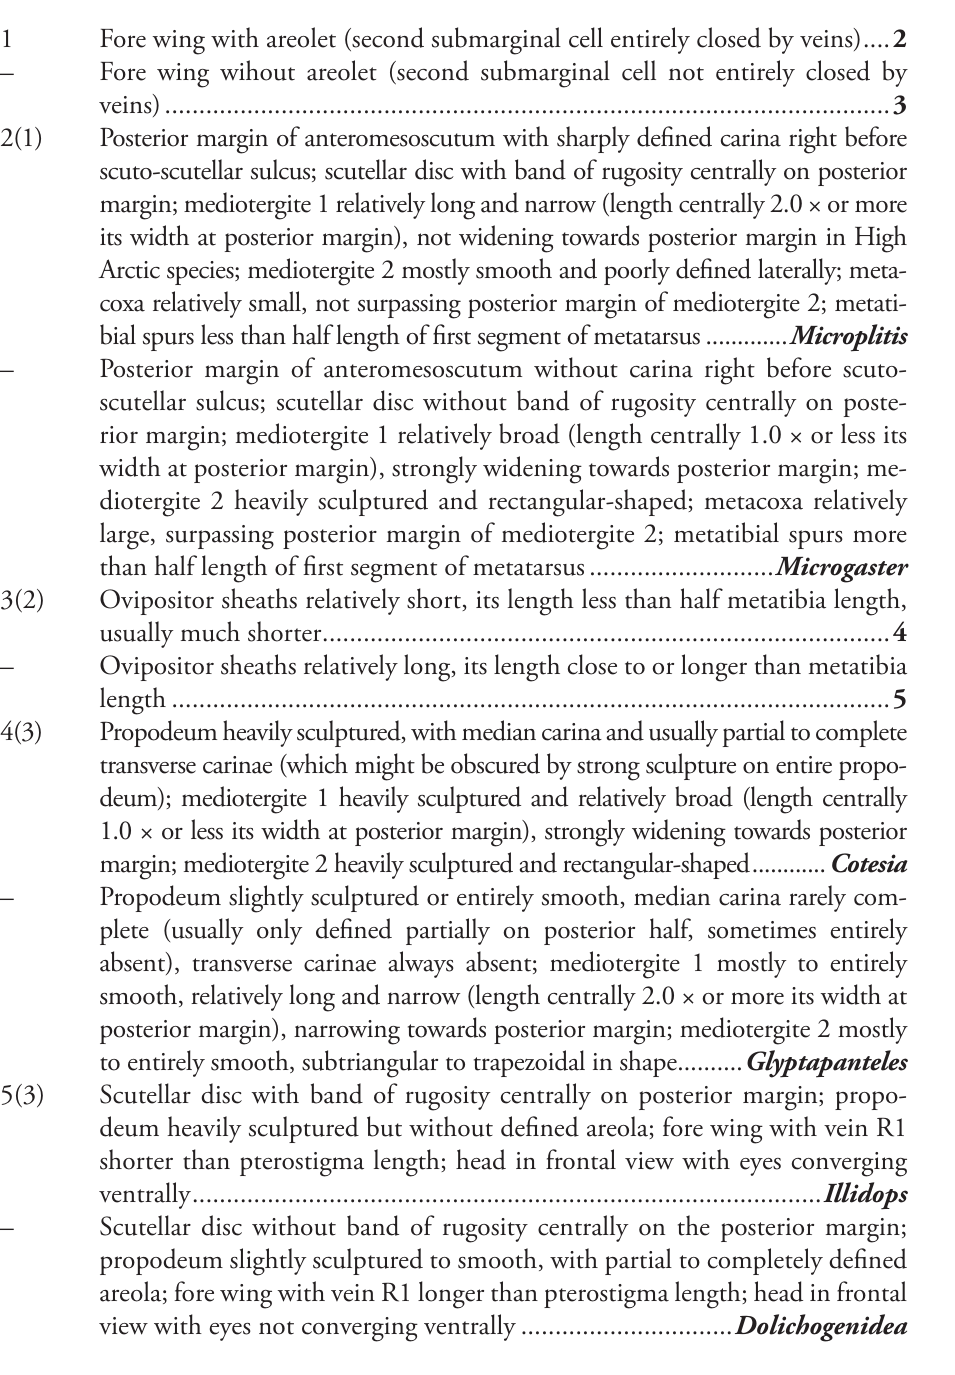
Fore wing with areolet (second submarginal cell entirely closed by veins) .... 2 Fore wing wihout areolet (second submarginal cell not entirely closed by 2(1) Posterior margin of anteromesoscutum with sharply defined carina right before scuto-scutellar sulcus; scutellar disc with band of rugosity centrally on posterior margin; mediotergite 1 relatively long and narrow (length centrally 2.0 × or more its width at posterior margin), not widening towards posterior margin in High Arctic species; mediotergite 2 mostly smooth and poorly defined laterally; meta- coxa relatively small, not surpassing posterior margin of mediotergite 2; metati- bial spurs less than half length of first segment of metatarsus ............. Microplitis – Posterior margin of anteromesoscutum without carina right before scuto- scutellar sulcus; scutellar disc without band of rugosity centrally on poste- rior margin; mediotergite 1 relatively broad (length centrally 1.0 × or less its width at posterior margin), strongly widening towards posterior margin; me- diotergite 2 heavily sculptured and rectangular-shaped; metacoxa relatively large, surpassing posterior margin of mediotergite 2; metatibial spurs more than half length of first segment of metatarsus ........................... Microgaster 3(2) Ovipositor sheaths relatively short, its length less than half metatibia length, usually much shorter ................................................................................... 4 – Ovipositor sheaths relatively long, its length close to or longer than metatibia length ......................................................................................................... 5 4(3) Propodeum heavily sculptured, with median carina and usually partial to complete transverse carinae (which might be obscured by strong sculpture on entire propo- deum); mediotergite 1 heavily sculptured and relatively broad (length centrally 1.0 × or less its width at posterior margin), strongly widening towards posterior margin; mediotergite 2 heavily sculptured and rectangular-shaped ............ Cotesia – Propodeum slightly sculptured or entirely smooth, median carina rarely com- plete (usually only defined partially on posterior half, sometimes entirely absent), transverse carinae always absent; mediotergite 1 mostly to entirely smooth, relatively long and narrow (length centrally 2.0 × or more its width at posterior margin), narrowing towards posterior margin; mediotergite 2 mostly to entirely smooth, subtriangular to trapezoidal in shape .......... Glyptapanteles Scutellar disc with band of rugosity centrally on posterior margin; propo- deum heavily sculptured but without defined areola; fore wing with vein R1 shorter than pterostigma length; head in frontal view with eyes converging – Scutellar disc without band of rugosity centrally on the posterior margin; propodeum slightly sculptured to smooth, with partial to completely defined areola; fore wing with vein R1 longer than pterostigma length; head in